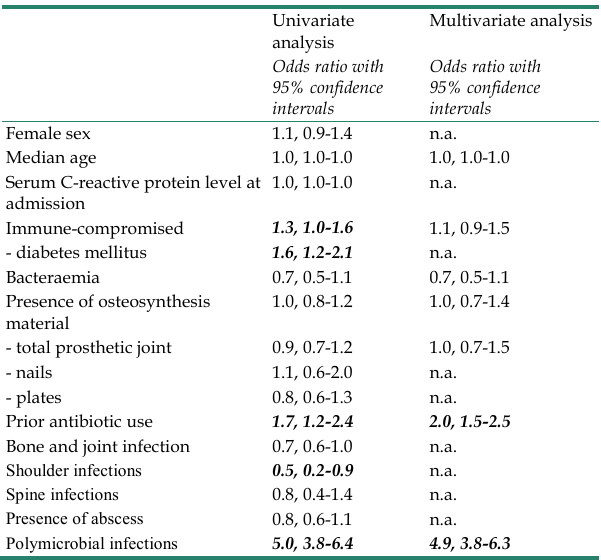
Table 4 . Logistic regression analysis with outcome “Gram- negative